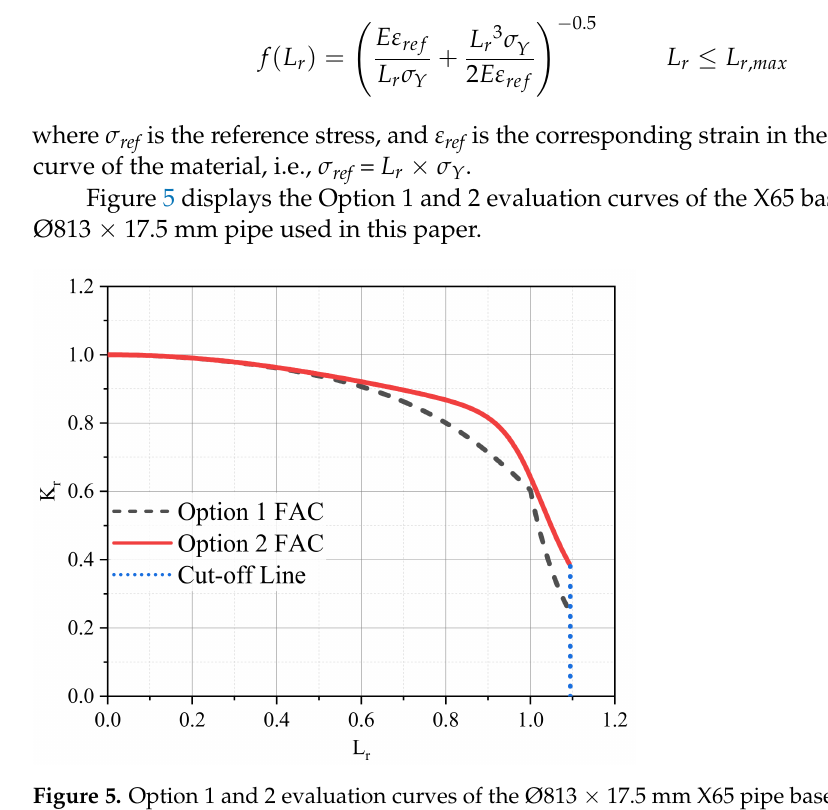
Figure 5. Option 1 and 2 evaluation curves of the Ø813 × 17.5 mm X65 pipe base